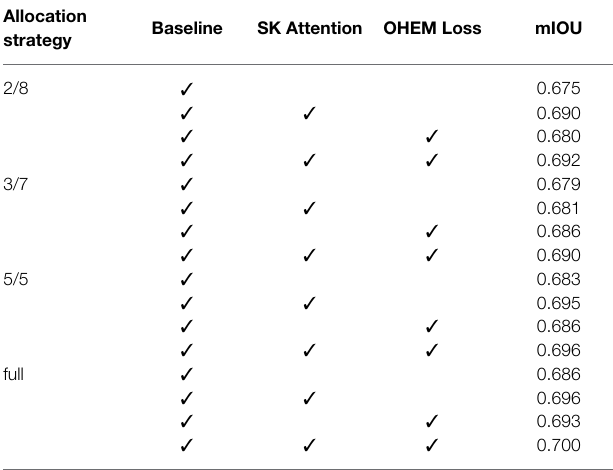
TABLE 2 | Ablation study under different labelled data proportion. TABLE 1 | Comparison with the baseline (SupOnly, i.e., using only supervised